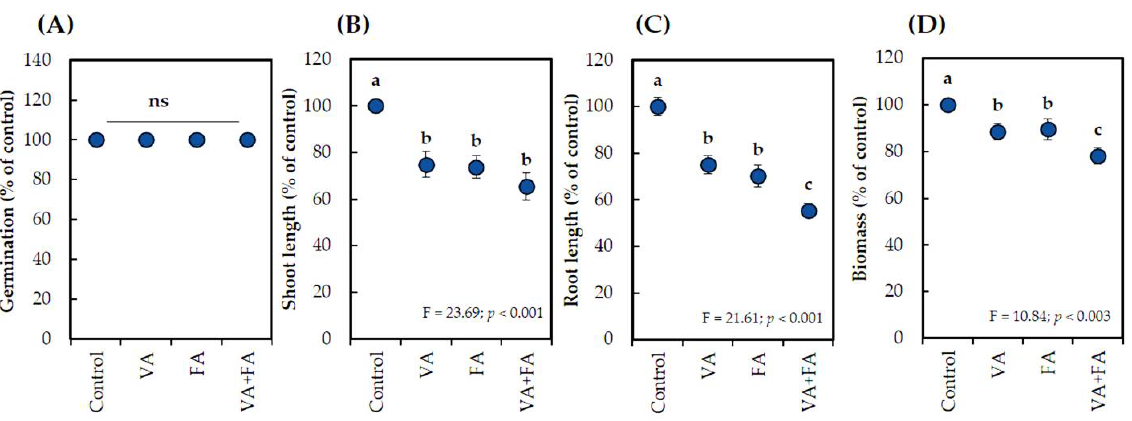
Figure 5. Growth inhibitory effects of a mixture of vanillic acid (VA) and ferulic acid (FA) at a concentration of 0.3 mM on ( A ) seed germination, ( B ) shoot length, ( C ) root length, and ( D ) dry biomass of L. sativum. Values are the mean (±S.D.) of three replicates (n = 30); different letters on each bar indicate a statistically significant difference between treatments (Tukey’s HSD, at the 0.05 probability level).